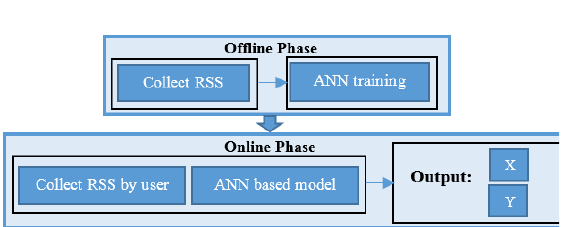
Figure 3. Multilayer perceptron:proposed model